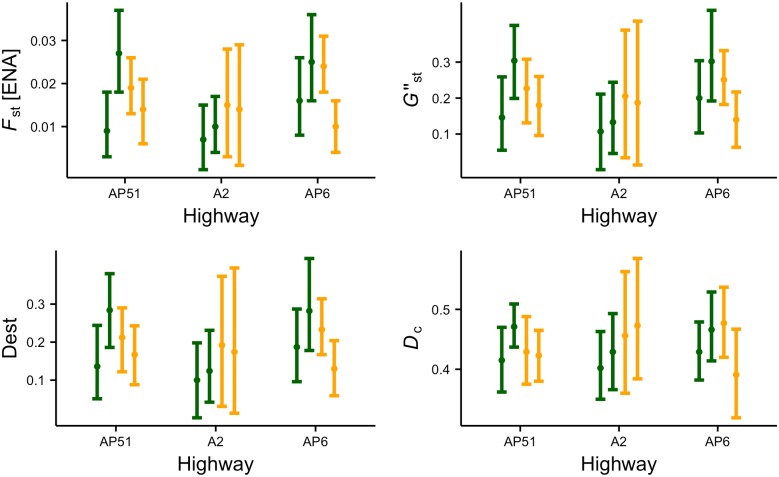
Comparison of genetic patterns for the three highways obtained from FST using ENA, G”ST, DEST and Dc.Green and orange lines represent the genetic differentiation observed between, respectively, sampling lines on opposite roadsides and on the same roadside. Dots represent mean values and limits are 95% confidence intervals.